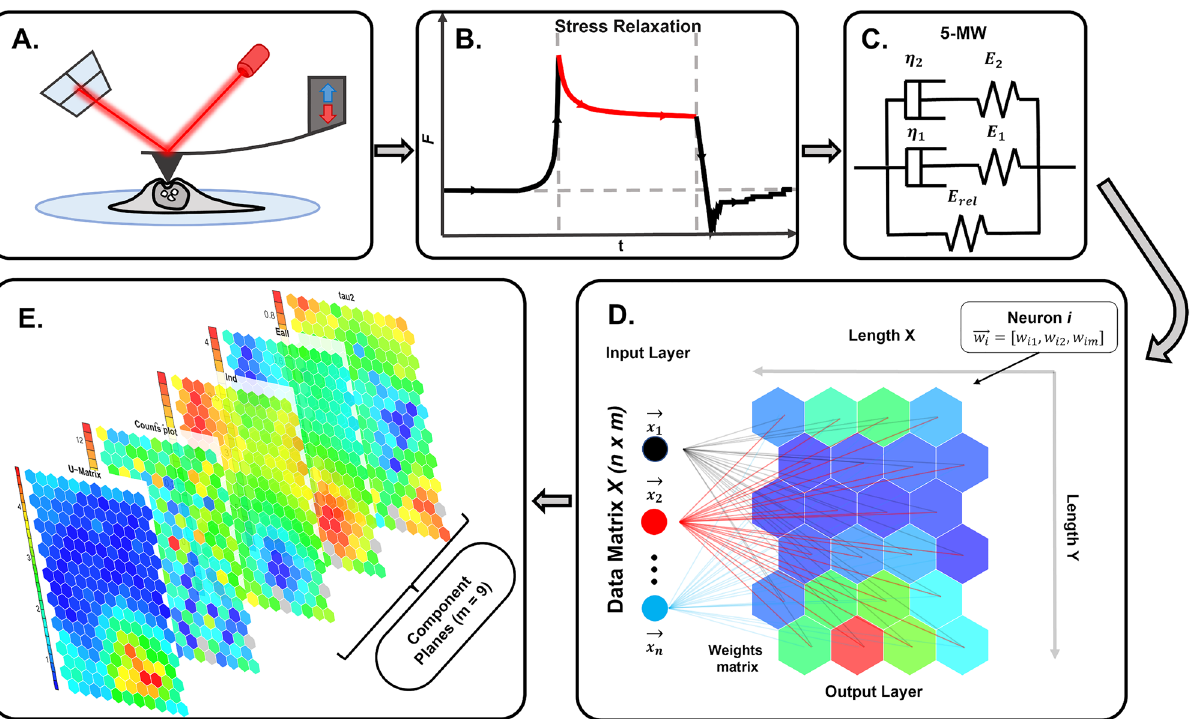
Figure 3. Methodology of the present study. ( A ) Cell viscoelastic properties are measured using stress relaxation experiments with AFM. ( B ) and ( C ). The resulting stress relaxation segment (force decay over time while keeping the deformation constant) is fitted using a five-element Maxwell model. This results in 9 input variables. ( D ) A self-organizing map is trained unsupervised. ( E ). The complex interconnectivity of the data can be represented in 2D maps, allowing for data